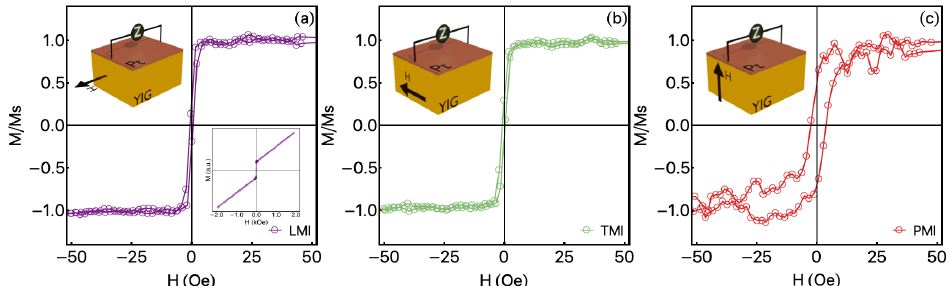
Figure 3. Normalized magnetization curves for the YIG/Pt bilayer acquired with the field along different orientations, ( a ) LMI, in which the external magnetic field is parallel to the drive current on the MI experiment. ( b ) TMI, here the external magnetic field is applied in the film-plane, and perpendicular to the drive current (MI experiment). ( c ) PMI configurations, which the external magnetic field is perpendicular to the film-plane. It is worth mentioning that the paramagnetic contribution of the GGG substrate is removed from each curve and, therefore, only the ferrimagnetic response of the YIG is seen here. The inset in ( a ) shows a representative example of the magnetization curves before the remotion of the paramagnetic